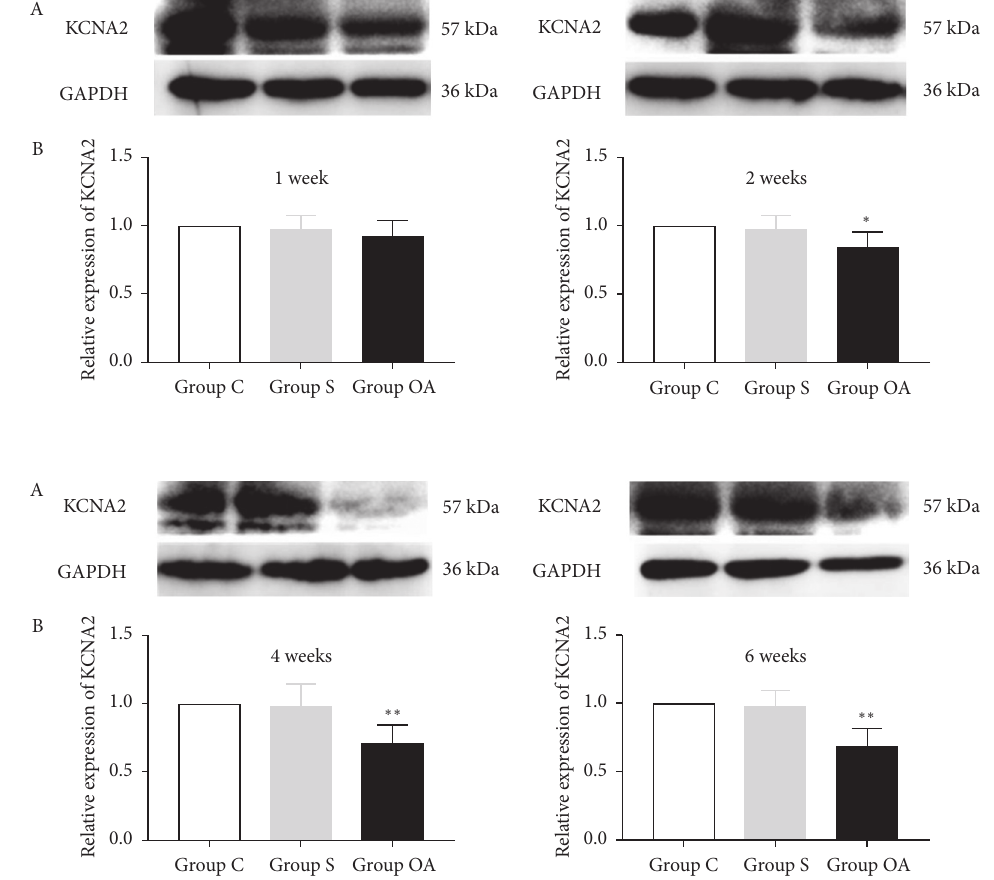
Figure 4: Comparison of KCNA2 expression in the three groups of rats at each time point. (a) Expression of KCNA2 in the DRG imaged by Western blotting. (b) Analysis of expression of KCNA2. Each symbol represents mean ± SD (standard deviation), n � 4 per group; ∗ P < 0 . 05, ∗∗ P < 0 . 01 vs. group C. One-way ANOVA and LSD